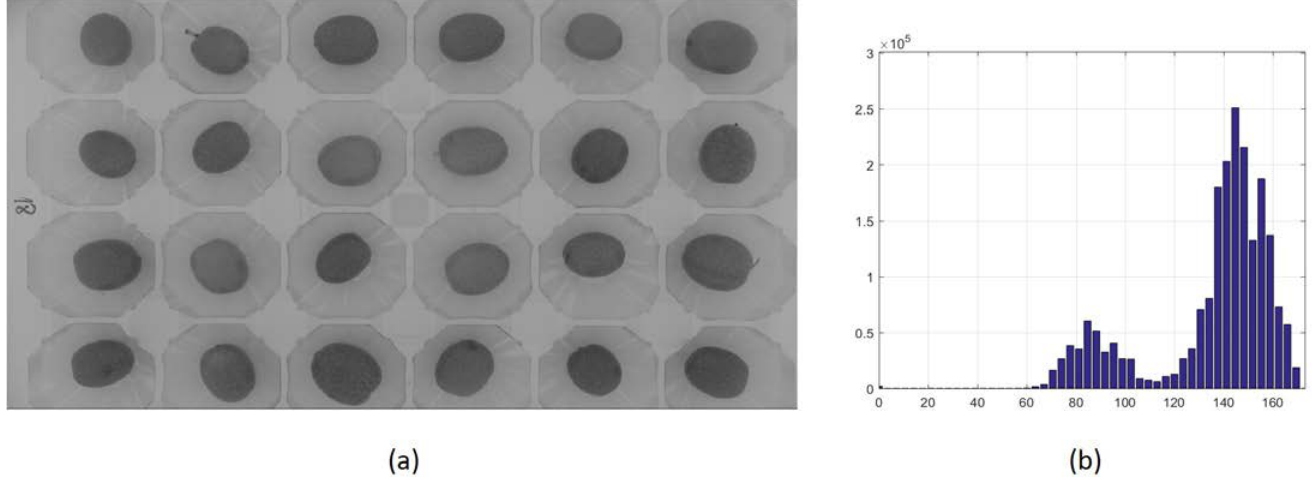
Figure 3. ( a ) Tray of recently collected olives, registered in c3 channel of the c1c2c3 model. ( b ) Histogram of c3 channel for this tray of olives.